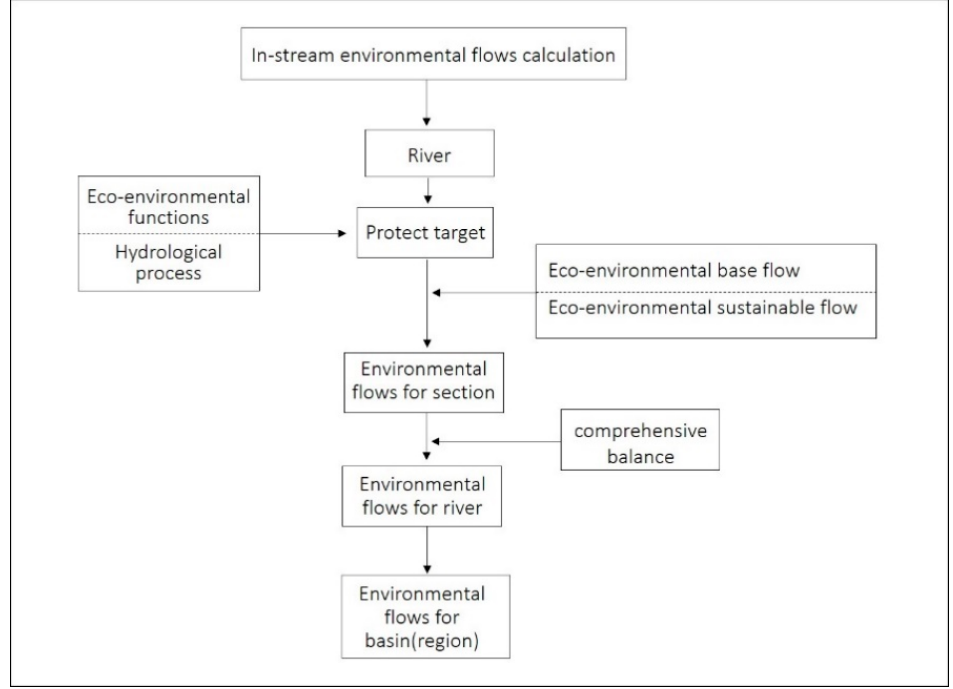
Figure 1. Framework for determining the in-stream environmental flows in SERL.